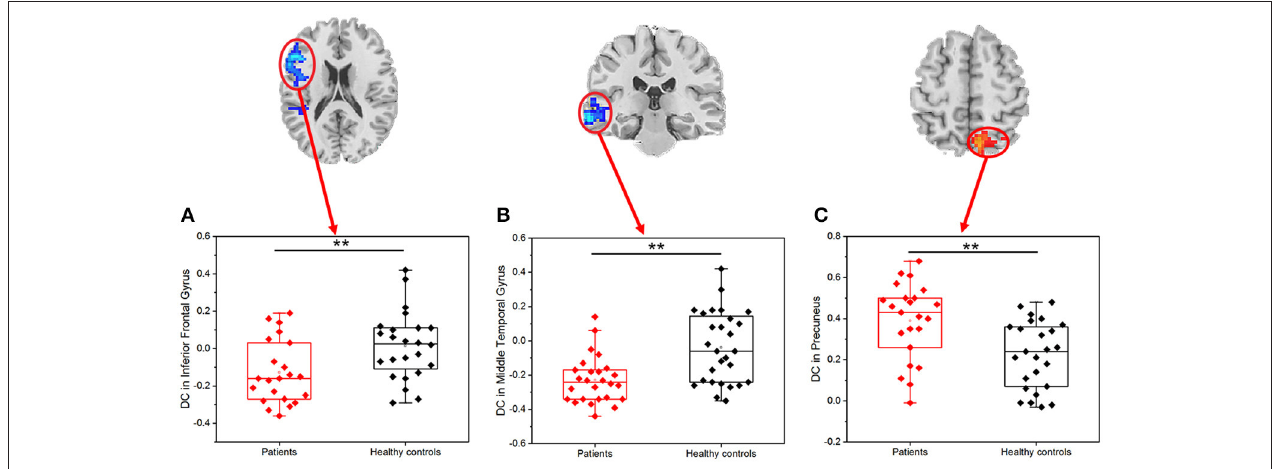
FIGURE 2 | Scatter plot of DC for the significantly decreased (increased) clusters between PI patients and healthy controls ( r 0 = 0.25). The difference between PI patients and healthy controls based on the DC in the left inferior frontal gyrus (A) , left middle temporal gyrus (B) , and right precuneus (C) ; Red dots: PI patients; black dots: healthy controls. Error bars represent standard deviation of the mean (** P <